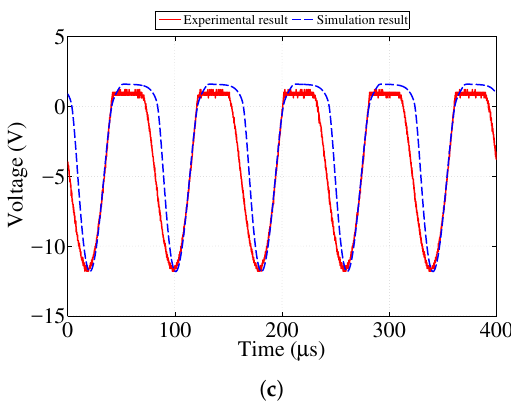
Figure 8. Simulation and experimental voltage data across 0.9 mm strip LED showing response at various resistances. ( a ) 100 k Ω resistance (just above threshold); ( b ) 200 k Ω resistance (far above threshold); ( c ) 32.5 k Ω resistance (below